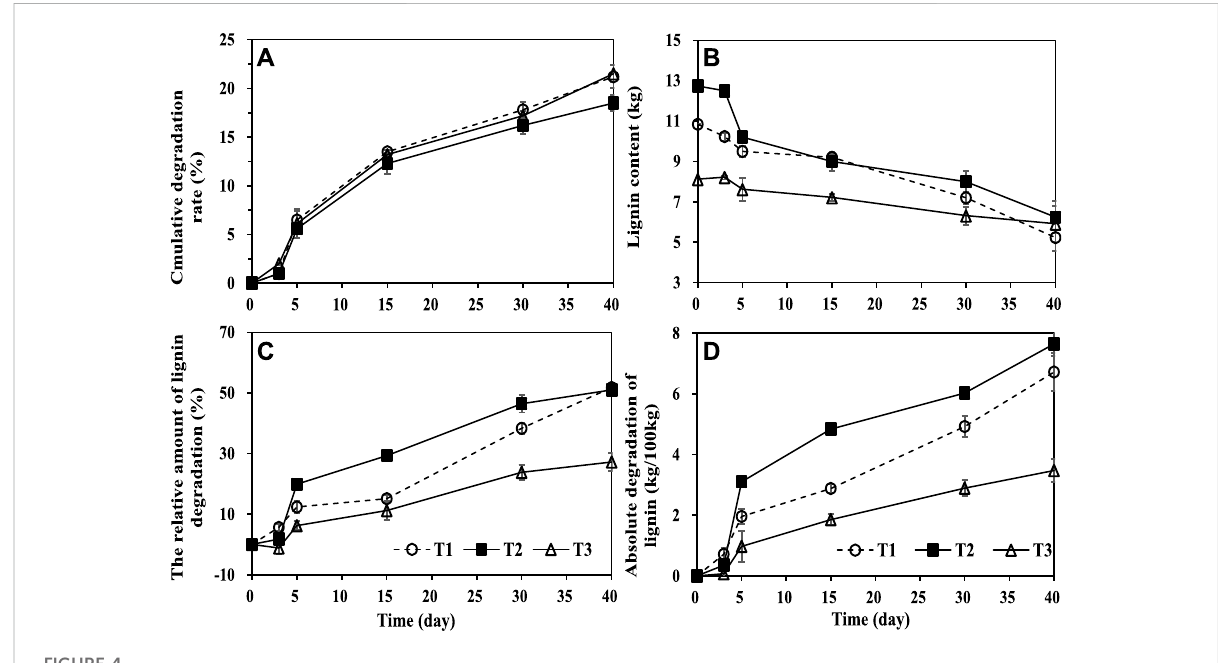
FIGURE 4 The degradation rate changes in the raw material and lignin in mixed material